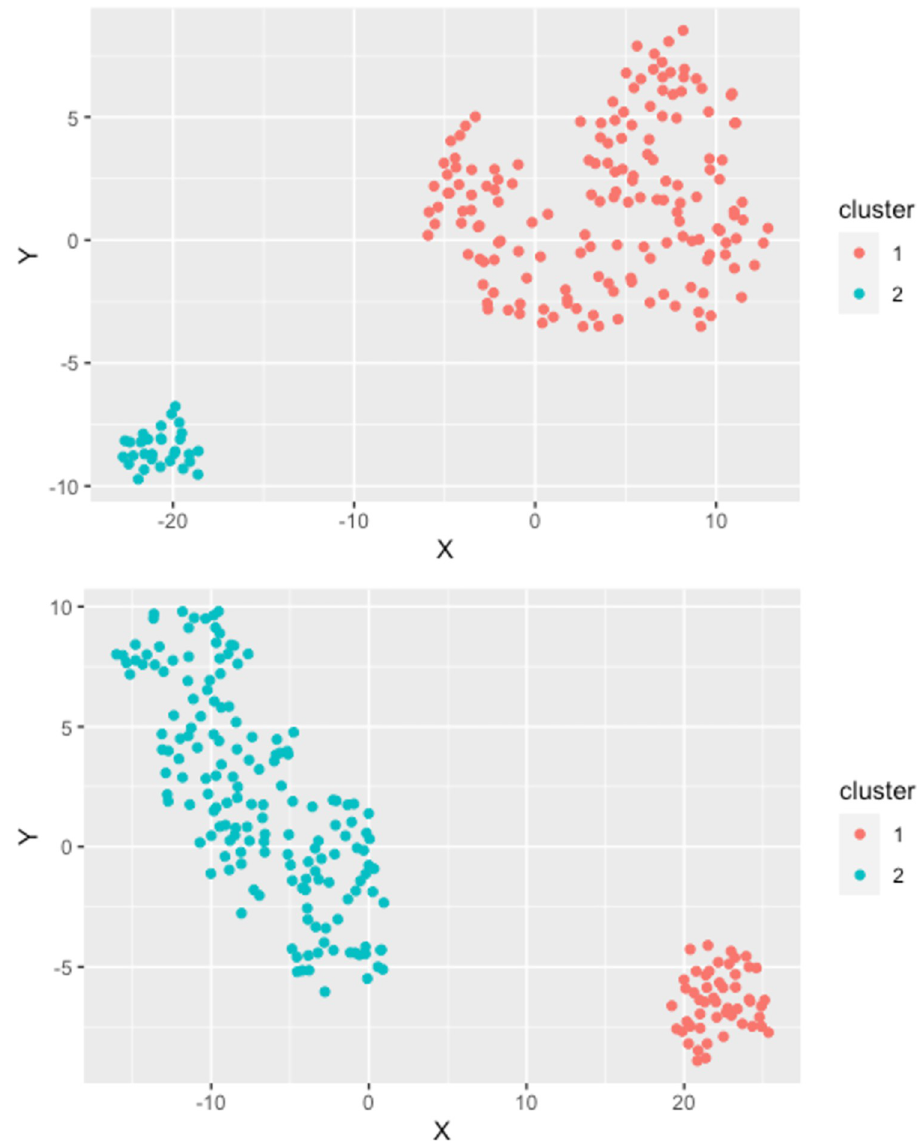
Fig 1. Cluster plot of the partitioning around medoids clustering process for F . hepatica (regions North and South). Region North (top): Two distinct clusters are displayed with 161 farms in cluster 1 (red) and 30 observations in cluster 2 (blue). Region South (bottom): Two clusters with 51 observations in cluster 1 (red) and 163 observations in cluster 2 (blue) naturally aggregated. Similarly, more organic farms were assigned to one cluster in all study regions compared with the other cluster. Positivity for. F . hepatica did not appear to as clearly distinguish between clusters as positivity for O . ostertagi did in the F . hepatica cluster analyses.